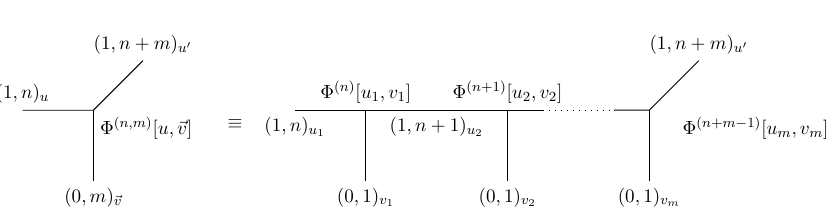
Figure 2 . (cid:8) ( n;m ) [ u;~v ] and (cid:8) ( n;m ) (cid:3) [ u;~v ].